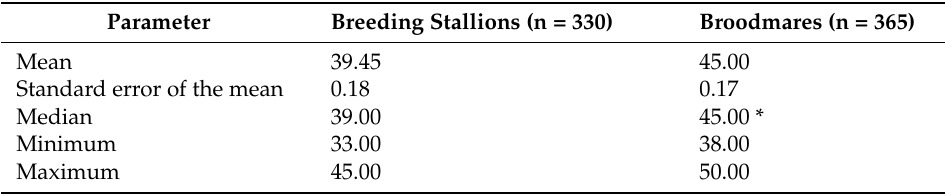
Table 7. The descriptive statistical parameters of the individual welfare scores in each breeding horse